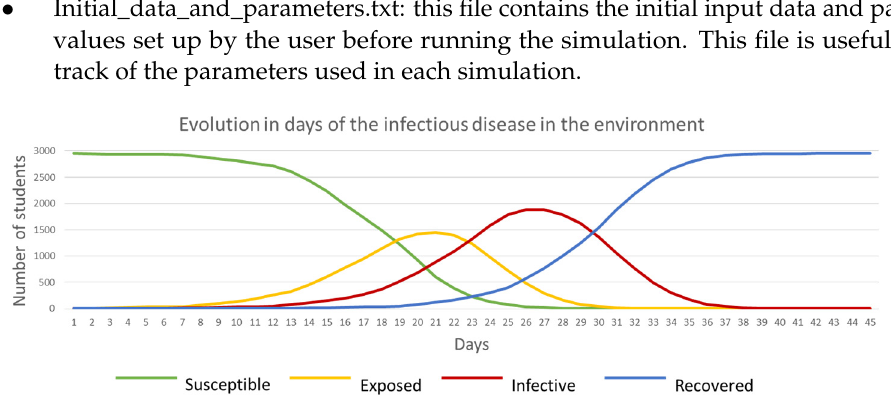
Figure 9. Example of the evolution in days of the infectious disease .